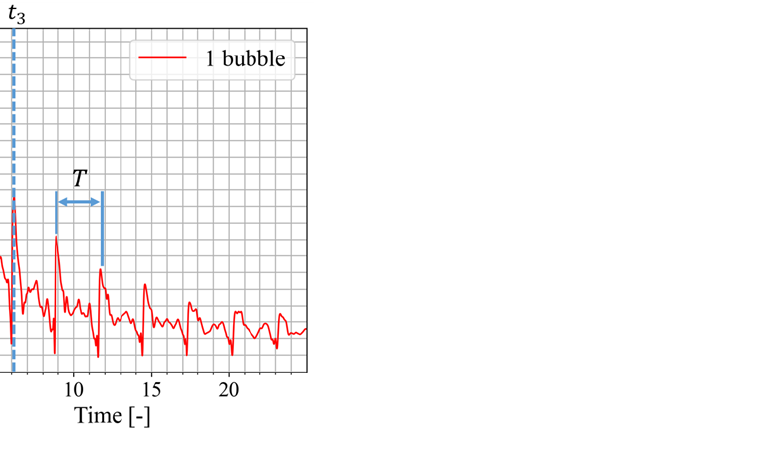
Figure 8. Time history of the pressure at the pressure probe in the case of the single bubble. The blue dashed line shows the arrival time of the pressure wave.